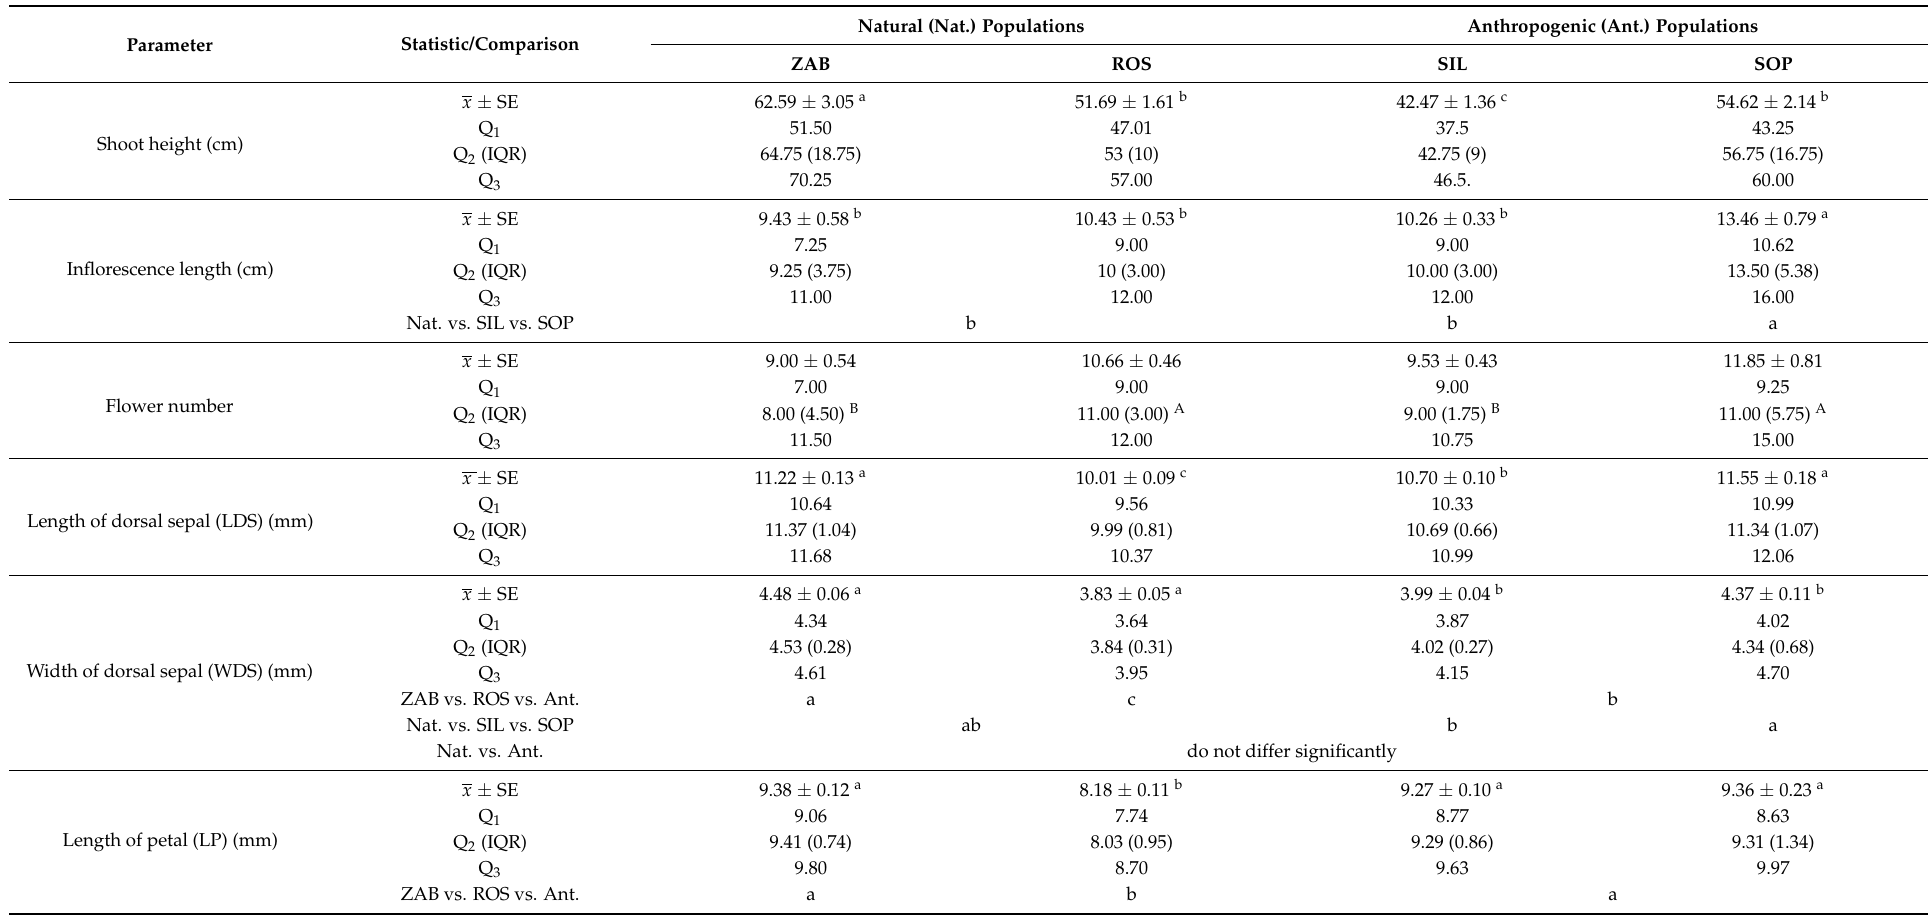
Table 1. Variation of floral display and flower structure in Epipactis palustris natural (Nat.) and anthropogenic (Ant.) populations. Data ( n = 30) represent the mean ( x ) ± standard error (SE), lower quartile (Q 1 ), median (Q 2 ), upper quartile (Q 3 ), and interquartile range (IQR). Different lowercase letters indicate statistically significant differences according to Tukey’s post-hoc test ( p < 0.05). Different uppercase letters indicate statistically significant differences according to the pairwise Wilcoxon Rank Sum test with Benjamini–Hochberg adjustment ( p < 0.05). Additional comparisons were shown only when populations within Nat. or Ant. (or both) do not differ significantly. Natural (Nat.) Populations Anthropogenic (Ant.) Populations Parameter Statistic/Comparison ZAB ROS SIL SOP